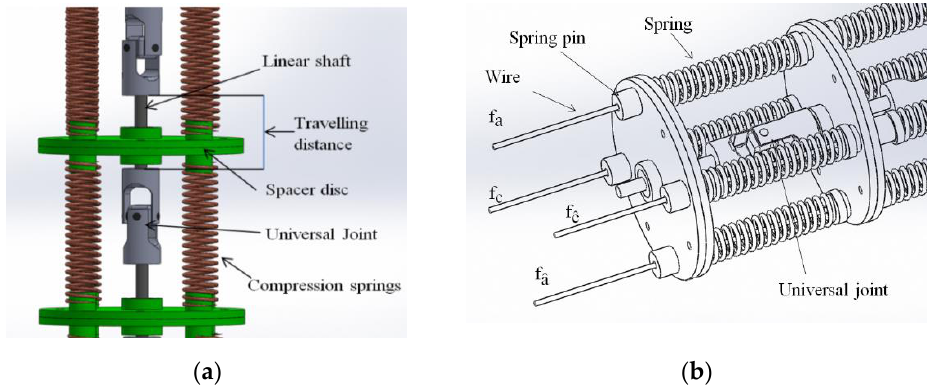
Figure 2. ( a ) TakoBot segment design and ( b ) transparent